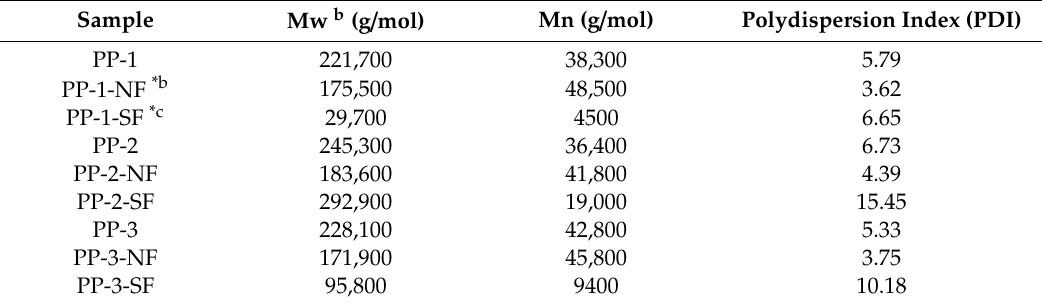
Table 4. GPC results.